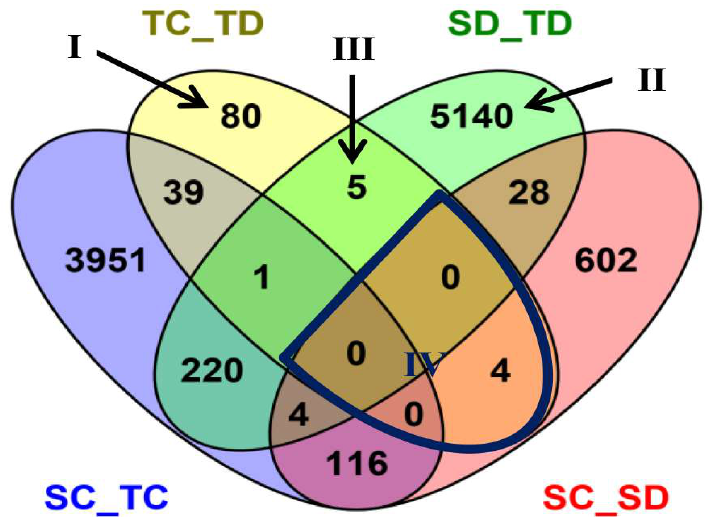
Figure 2. Venn diagram showing the profile of differentially expressed genes (DEGs). The differentiations were compared between inbred lines under each drought treatment, or between drought treatments in each inbred line. Drought treatments are labeled Control (C) and Drought (D). The tolerant line (YE8112) and the sensitive line (MO17) are labeled “T” and “S”, respectively. The four treatment-line biological samples are tolerant-control (TC), tolerant-drought (TD), sensitive-control (SC), and sensitive-drought (SD). Each compared combination is separated by an underscore (e.g., TC_TD). In the Venn diagram, the numbers of DEGs are shown across intersection areas among the compared combinations. In total we found 10,612 DEGs from all the areas. Four critical areas, labeled I, II, III, and IV, totally contain 5229 DEGs. Area I contains the tolerant treatment response DEGs, excluding others. Area II contains the line response under drought DEGs, excluding others. Area III contains both tolerance treatment response and line response under drought DEGs, excluding others. Area IV contains the treatment response DEGs within line.